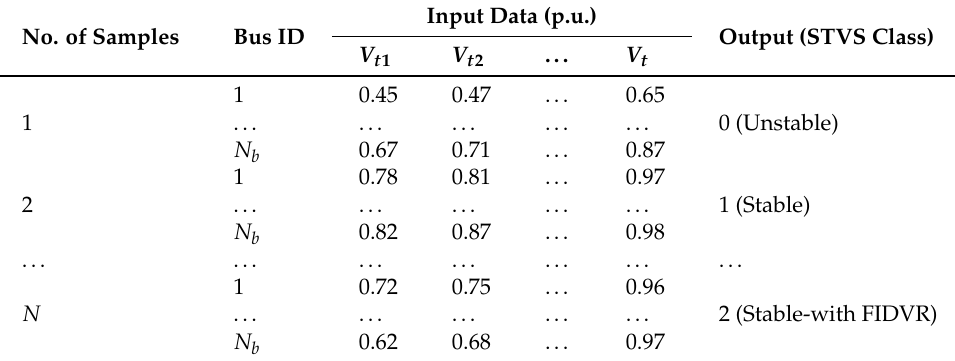
Figure 4. STVS evaluation and labeling process. Table 1. STVS assessment database